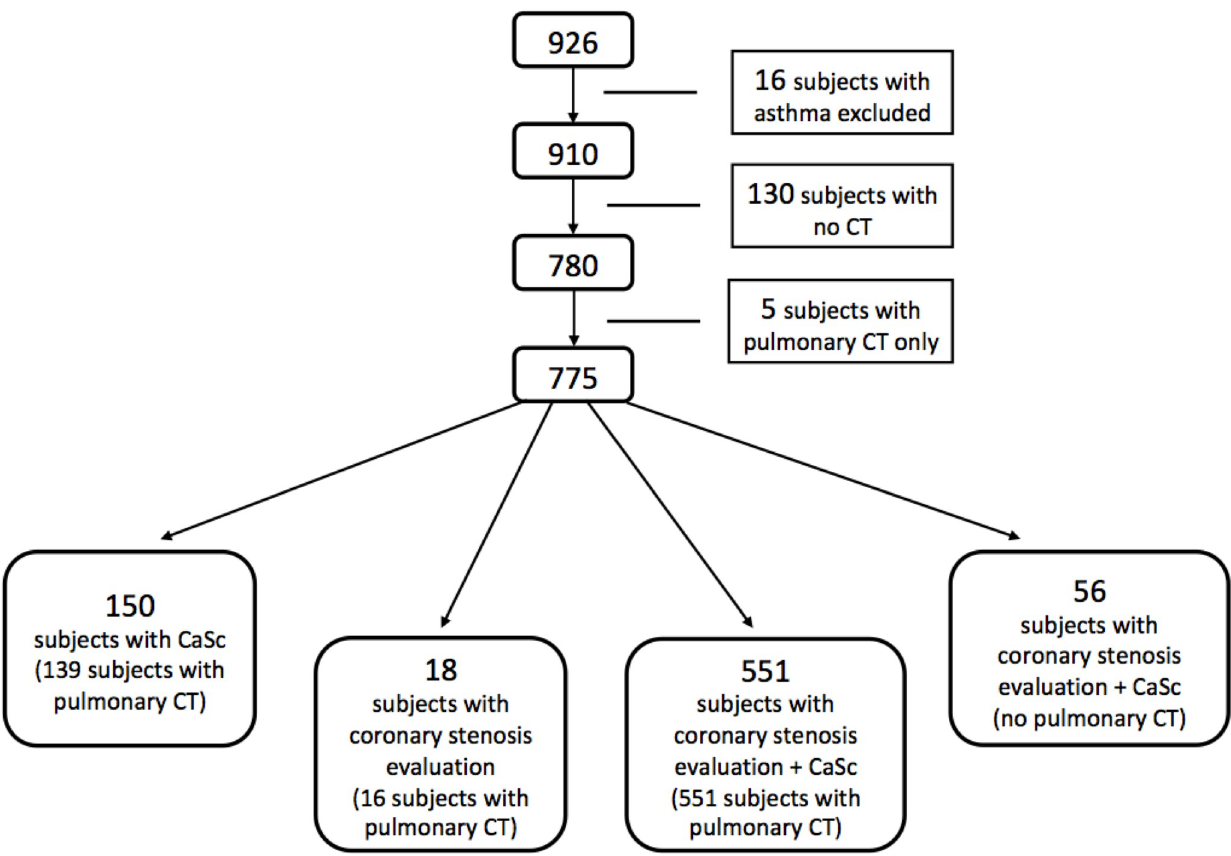
Fig 1. Flow chart of study selection and final CT data availability.